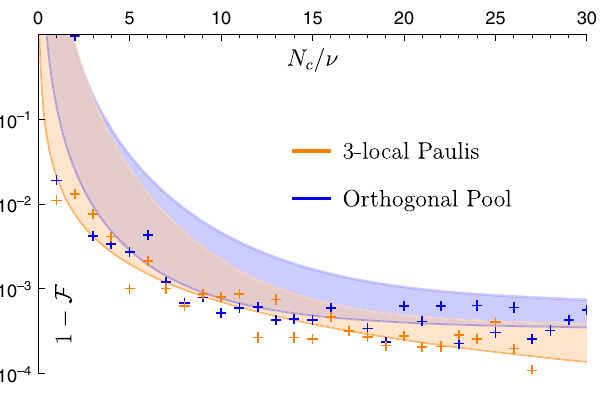
FIG. 10. Performance of recompiling the parameters of a 2-layer unitary on 14 qubits. Plot shows the minimum infidelity reached over 3 runs of 20 iterations of root finding with the ratio of constraints to ansatz parameters ν , for two different choices of operator pool with shot noise equivalent to taking 10 5 shots. Blue for orthogonal pool and orange for the set of all 3-local Pauli